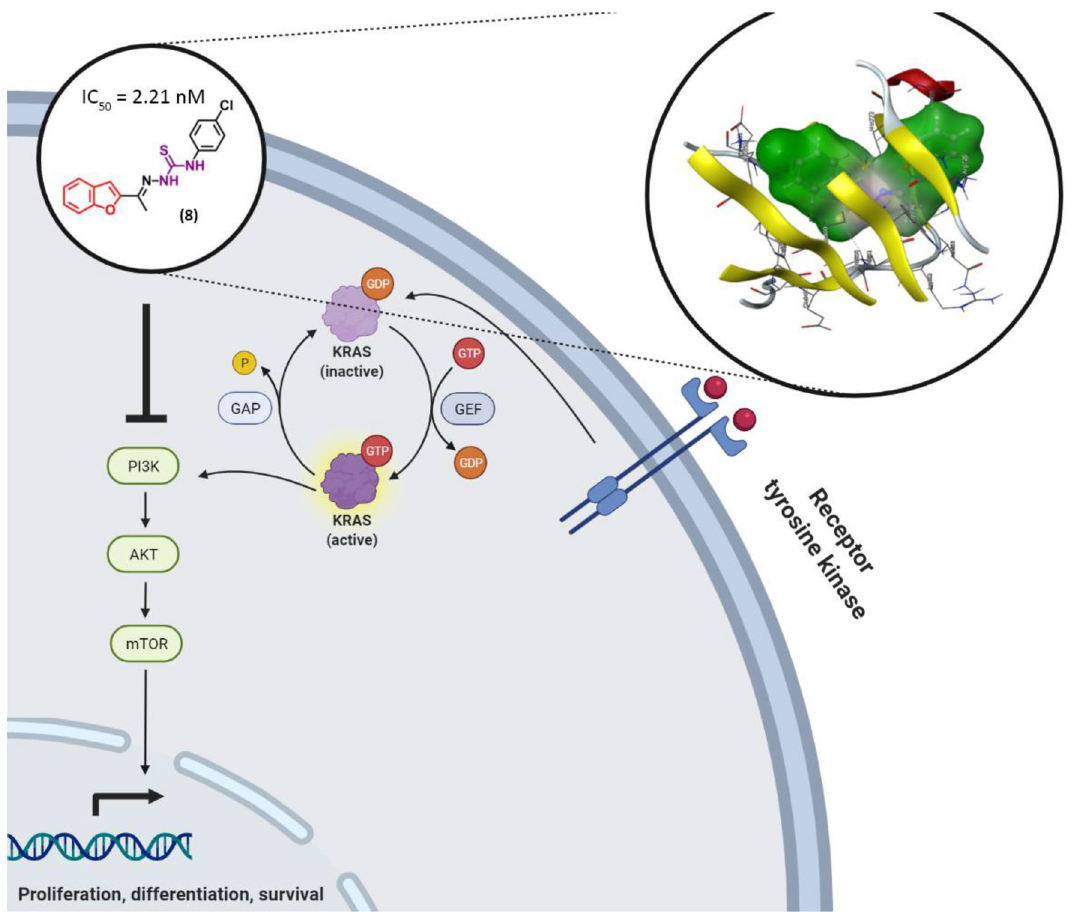
Figure 12. Illustration of inhibitory mechanism of compound 8 on PI3K